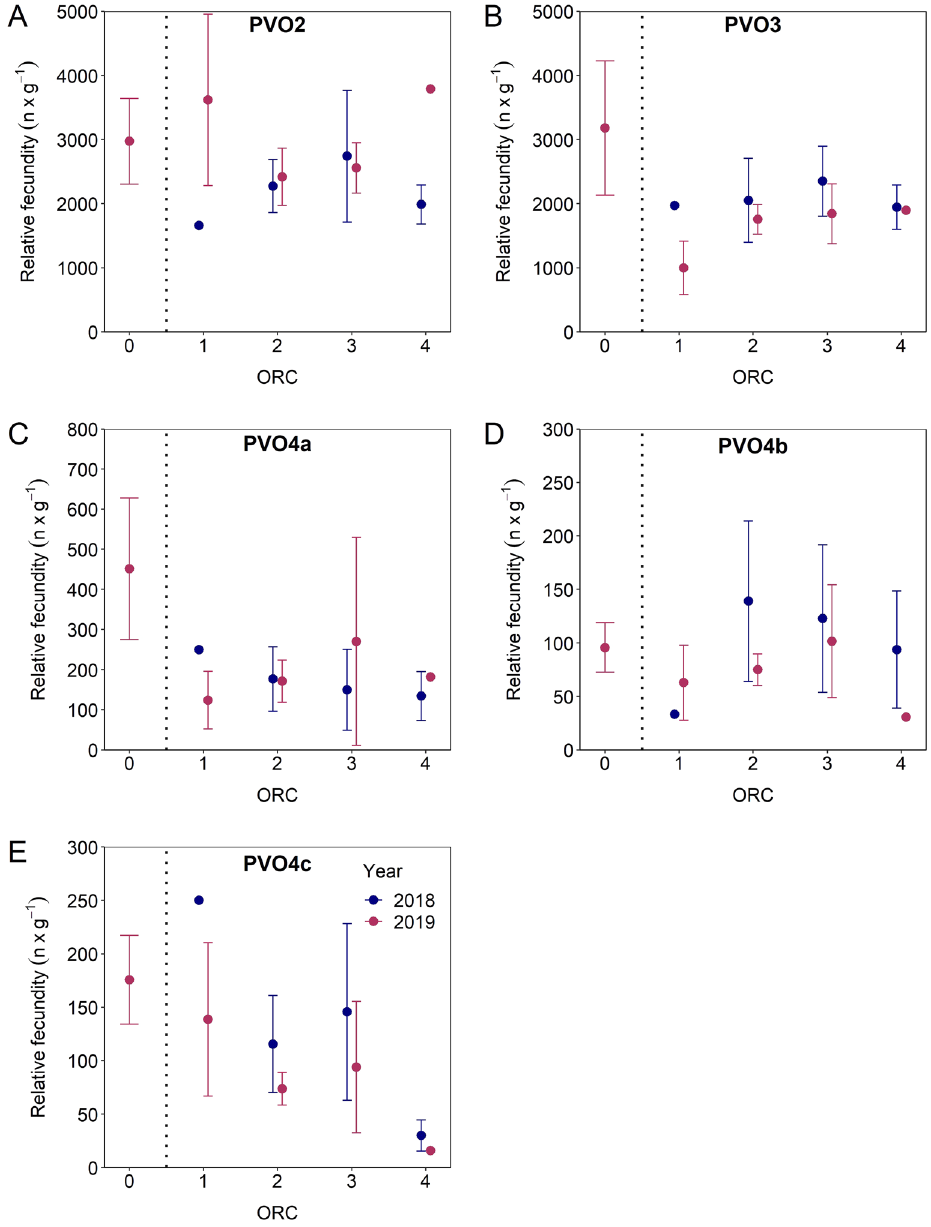
Figure 7. Mean (± 95% confidence interval) relative fecundity of previtellogenic oocytes in phases PVO2 to PVO4a–c by oocyte ratio category (ORC) split by 2018 and 2019. Vertical line separates prespawning individuals (ORC0) from those that have already started spawning (ORC1 to 4). Note that the y-axis scale differs between